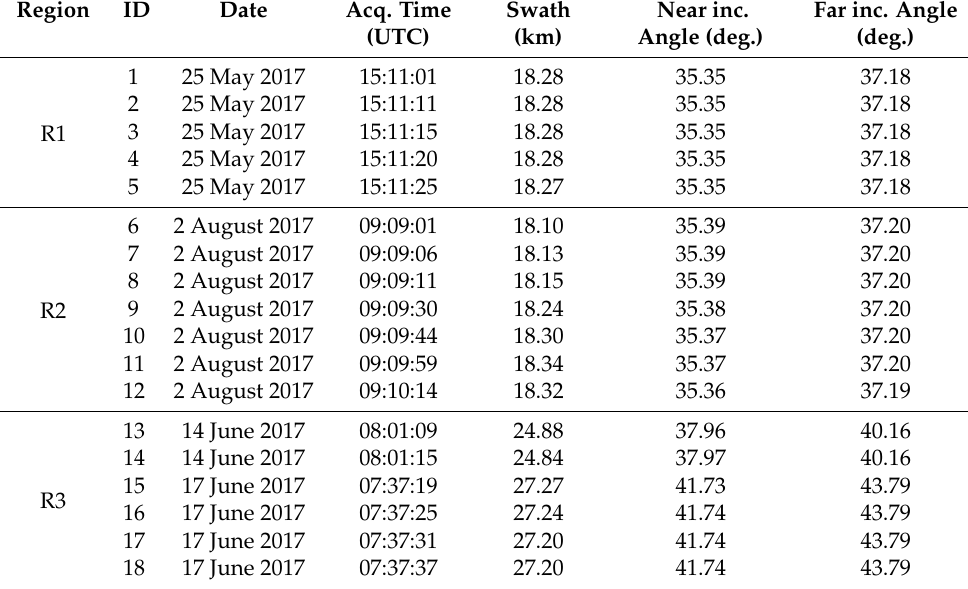
Figure 1. Geographical locations of the 18 Gaofen-3 (GF-3) quad-polarization Stripmap (QPS) mode overpasses used in this study. Table 1. Data of the 18 scenes from GF-3.